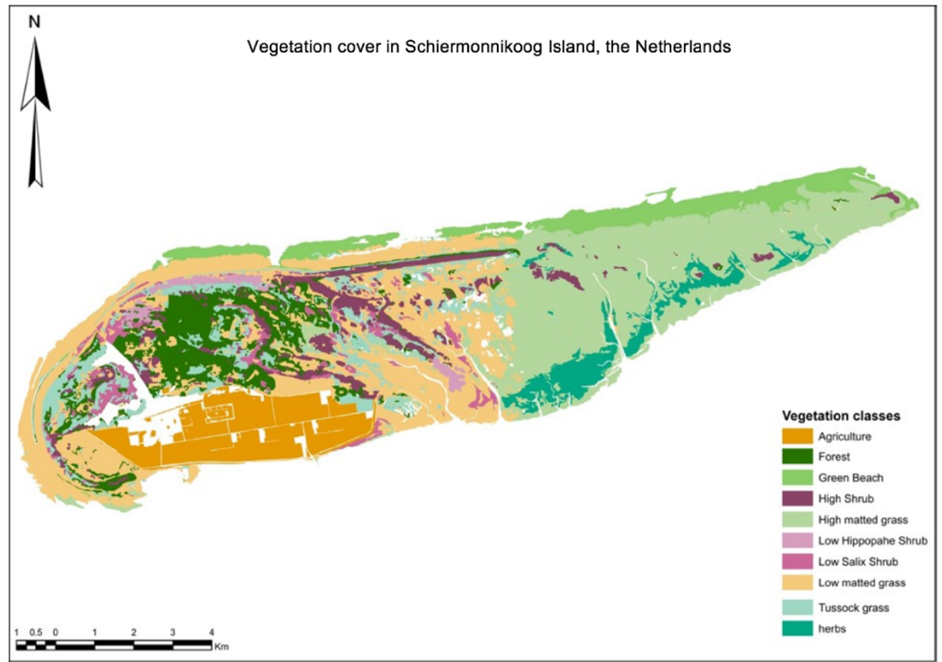
Figure 6. Classified map of the study area using the Group 4 of band combinations, red-edge spectral bands (as this group achieved the highest accuracy) of Sentinel-2 data, and the SSLES method.